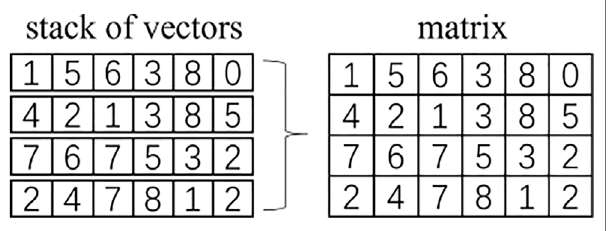
FIGURE 1 | Illustration of stacking 4 vectors of (6) into a single matrix (4, 6).